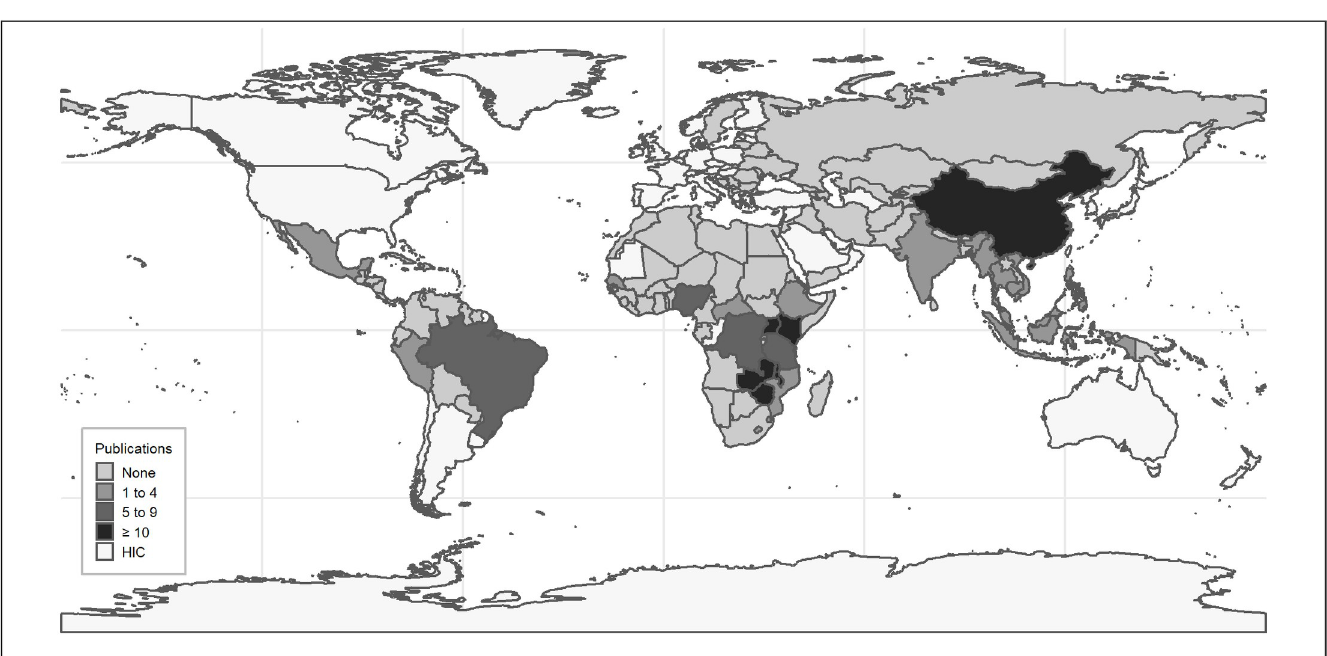
Fig 2. Frequency distribution of included studies according to country. Notes: HIC–high income country. Made with Natural Earth. Free vector and raster map data @ naturalearthdata.com.